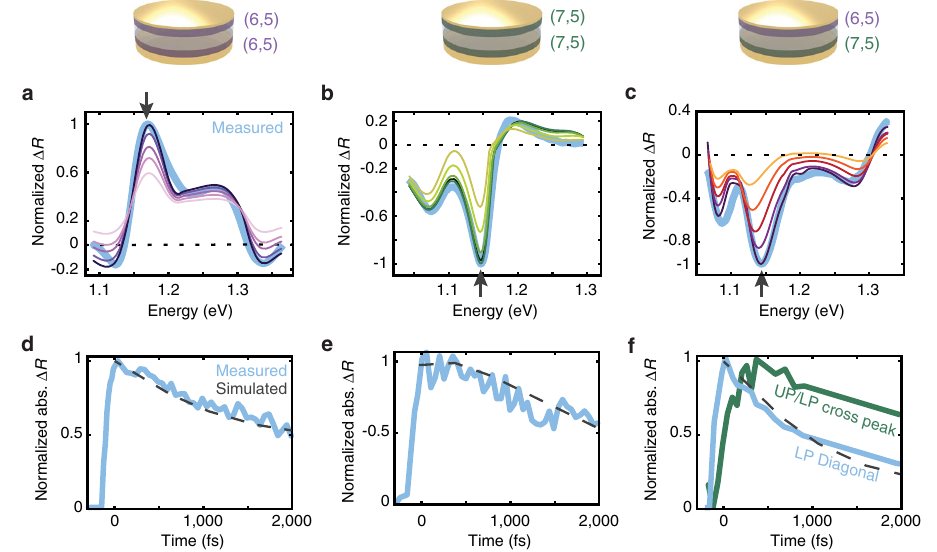
Fig. 3 | Simulated transient re fl ection spectra and Rabi contraction dynamics. Transient re fl ection spectra for the (6,5)- ( a ), (7,5)- ( b ), and mixed (6,5)/(7,5) microcavities ( c ) simulated using the transfer matrix method. Measured transient re fl ection spectra at T =100 fs are overlaid in light blue for comparison. The dark- to-light color gradient in each panel illustrates the gradual decrease of the bleachedpopulationovertime(seeSupplementaryFig.15fortheexactvalues).See Supplementary Note 2.2 and Supplementary Fig. 24 for additional details. d – f Measured kinetic traces (light blue solid lines) of the lower-polariton (LP)